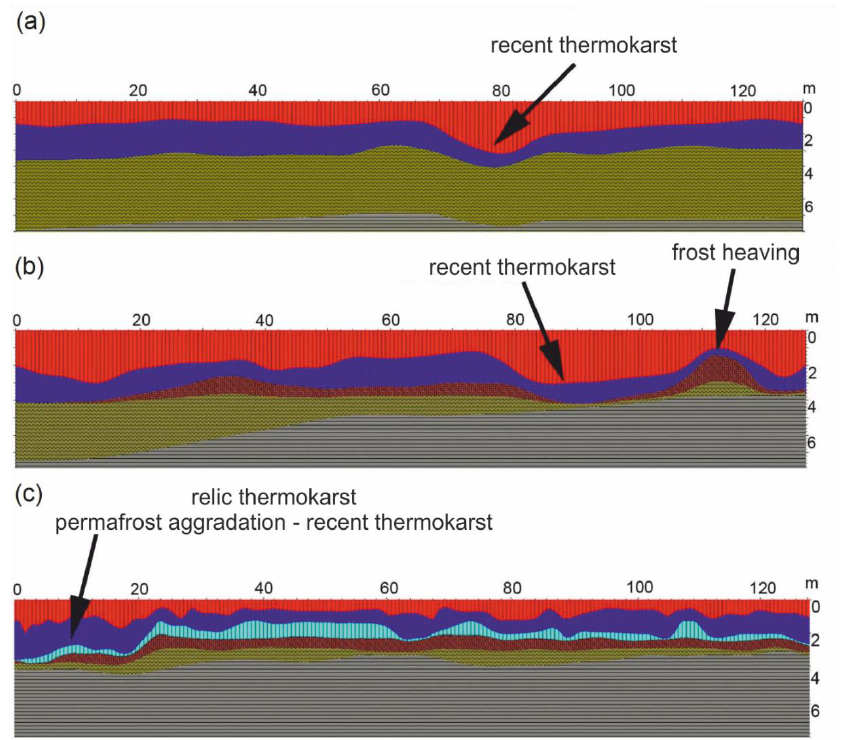
Figure 4. Typical traits of cryogenic processes in the sections: thermokarst of the transient layer ( a ), ( b ) and layer E ( c ); frost heaving ( b ); permafrost aggradation ( c ). Refer to the key of Figure